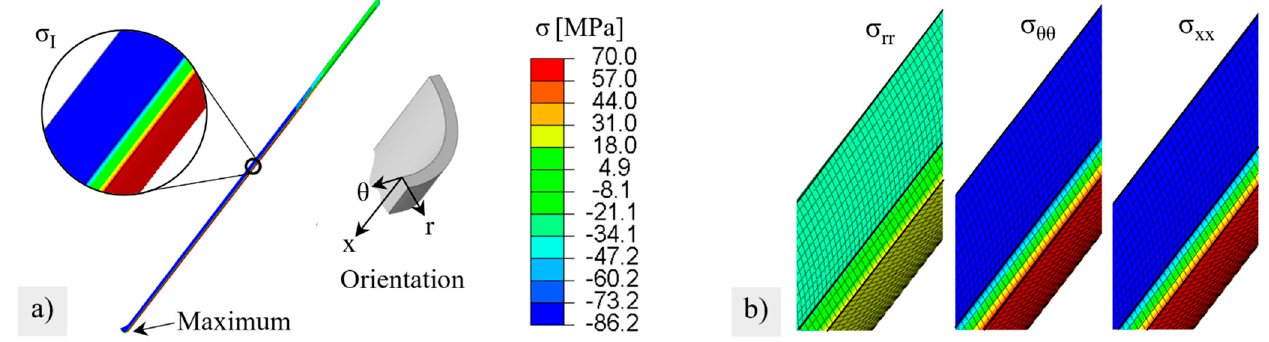
Figure 10. Stress distribution after virtual heating and pressurizing: ( a ) maximum principal stress ( b ) stress components consisting of radial σ rr , tangential σ θθ and axial stresses σ xx at the relative membrane length x = 0.5. The color legend is valid for ( a ) and ( b ).